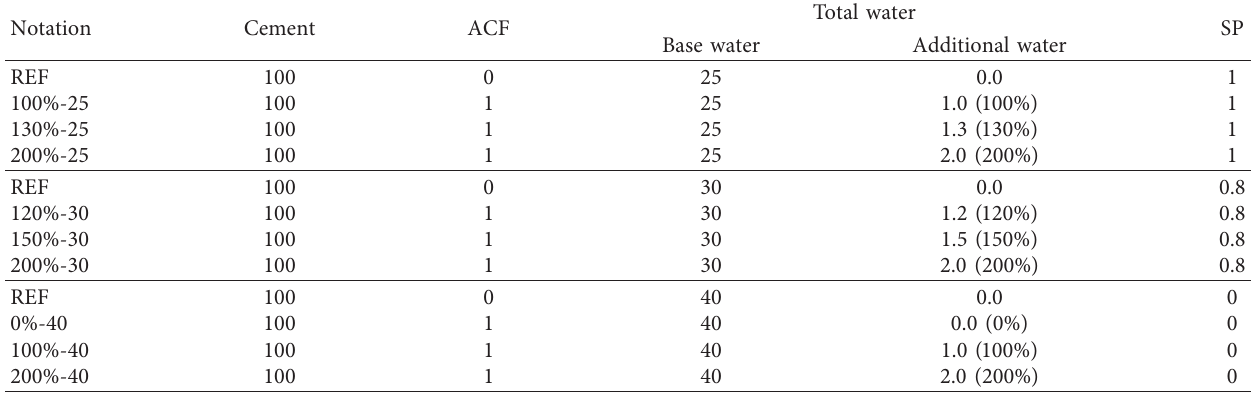
Table 3: Mixing proportions for part 2 (relative mass).